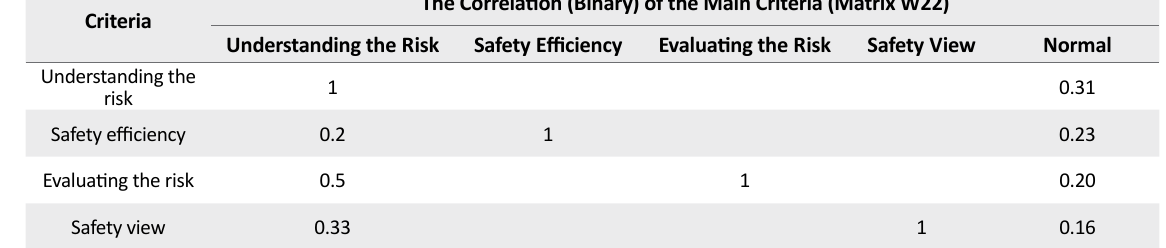
Table 1. The correlation (binary) of the main criteria of the health risk The Correlation (Binary) of the Main Criteria (Matrix W22) Criteria Understanding the